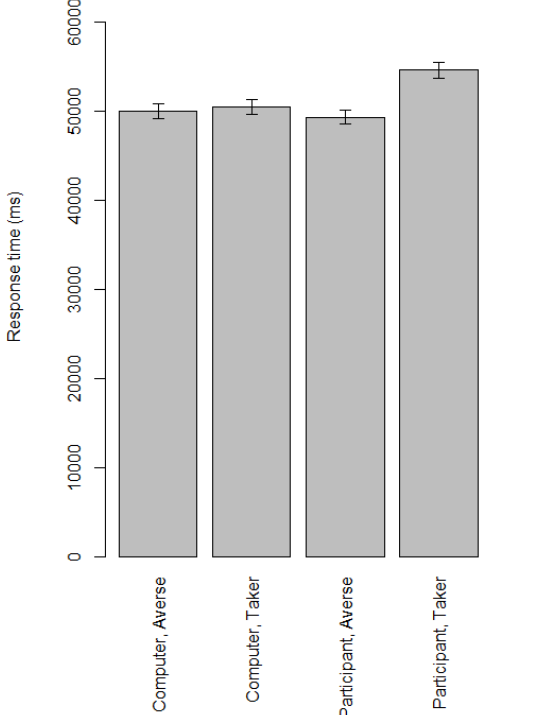
Figure 9. Reaction times in milliseconds for the automatically generated risk-based cognitive models in Game 4. “Computer-Averse”: the participant believes the computer is risk-averse in its decisions; “Computer-taker”: the participant believes the computer takes risks in its decisions; “Participant-Averse”: the participant says he/she avoids risks; and “Participant-Taker”: the participant says he/she takes